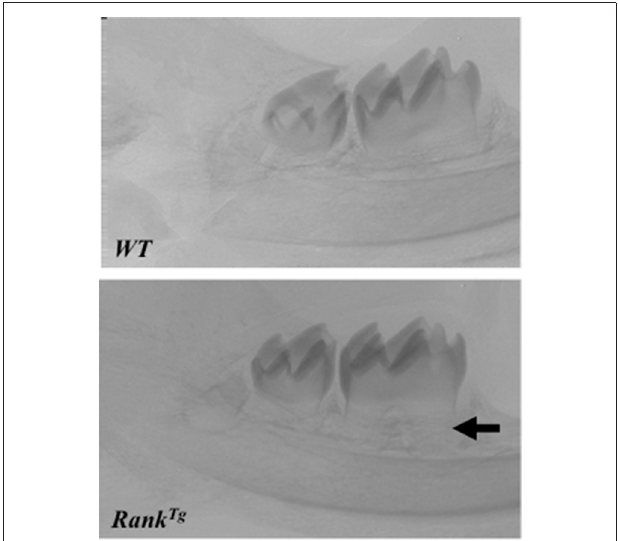
FIGURE 3 | Accelerated root elongation in RANK Tg mouse. Micro-CT section in the mandible main axis show in 11 day-old RANK Tg mouse a more advanced root elongation (arrow) compared to wild type mouse.